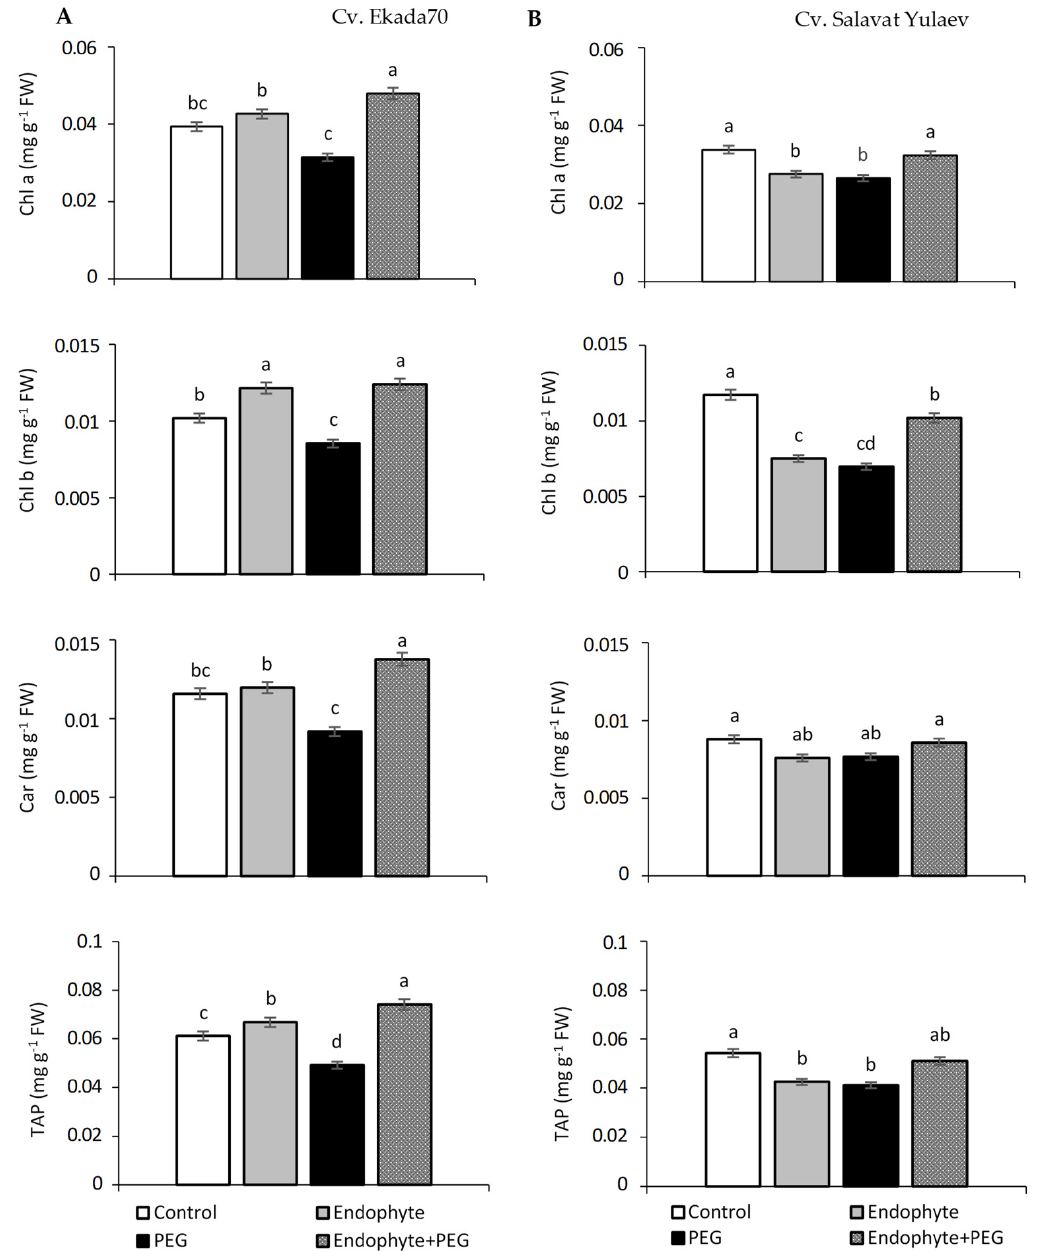
Figure 4. Effect of endophytic B. subtilis 10-4 (endophyte) on photosynthetic pigments in the leaves of wheat seedlings of cv. Ekada70 ( A ) and cv. Salavat Yulaev ( B ) under normal and drought stress conditions. Chl a—chlorophyll a; Chl b—chlorophyll b; Car—carotenoids; TAP—total amount of pigments. (n = 30, three replicates). Different letters indicate a significant difference between the means at the probability level of p < 0.05. Significant difference compared with the control ( p < 0.05). Drought exposure over 24 h resulted in a 2–3 fold decrease in the content of Chl a, Chl b, and Car in wheat leaves of both cultivars (Figures 4A,B). At the same time, wheat leaves primed with B.